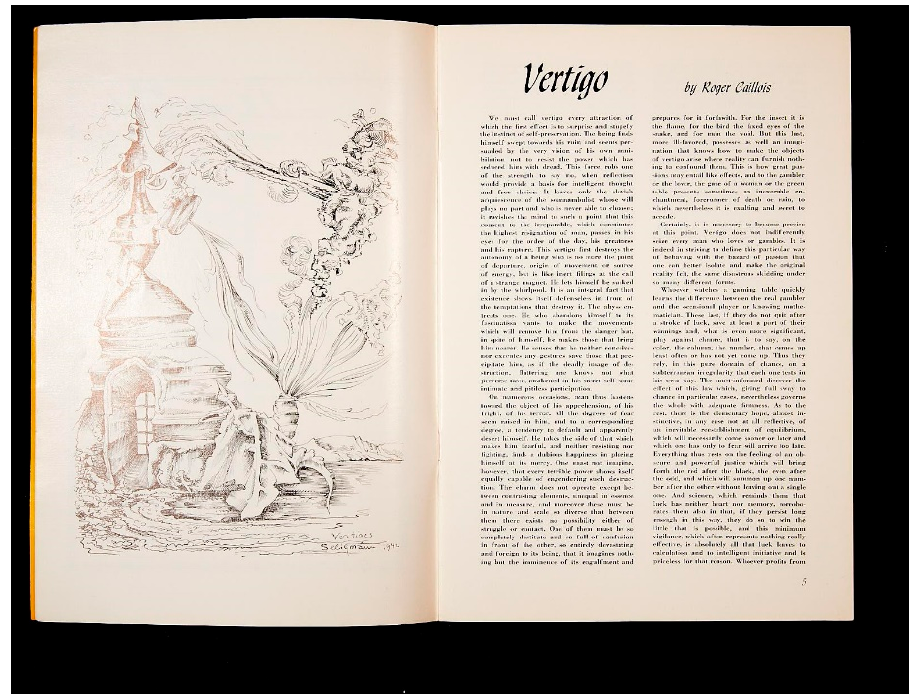
Figure 5. Kurt Seligmann, Vertiges , 1942, View , October 1942. © 2020 Orange County Citizens Foundation/Artists Rights Society (ARS), New York. Used with permission.